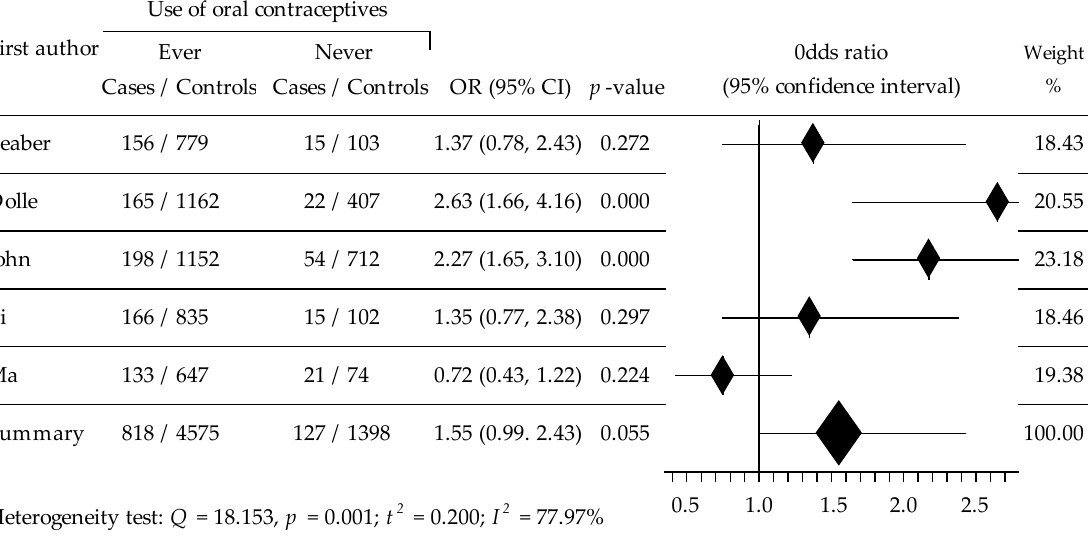
Figure 5. Forest plot for effects of OC use on the Triplet Negative subtype.